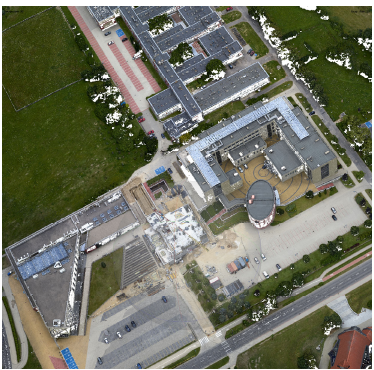
Figure 5 . Visualization of a part of the point cloud generated in the Agisoft Metashape application.